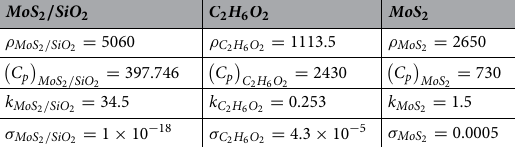
Table 1. Thermal properties of hybrid nanoparticles with base fluid.